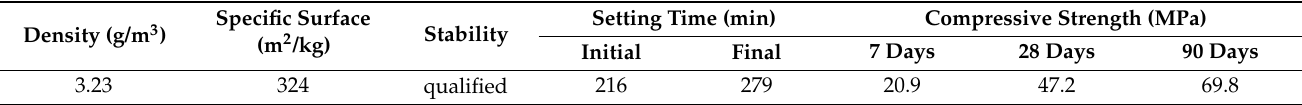
Table 2. Physical properties of cement.